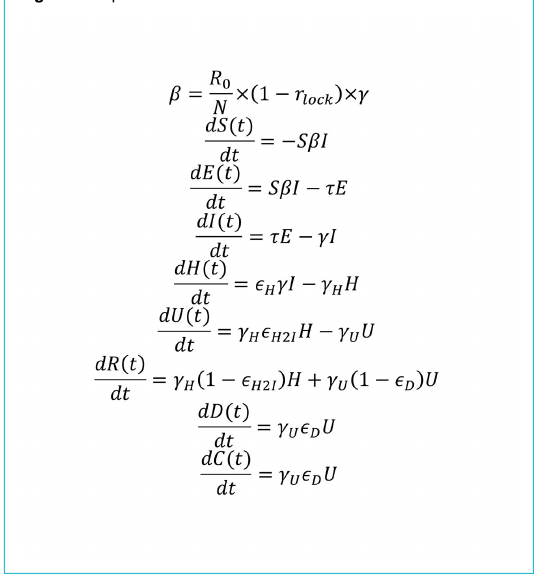
Figure 3: Equations used in the BT model.